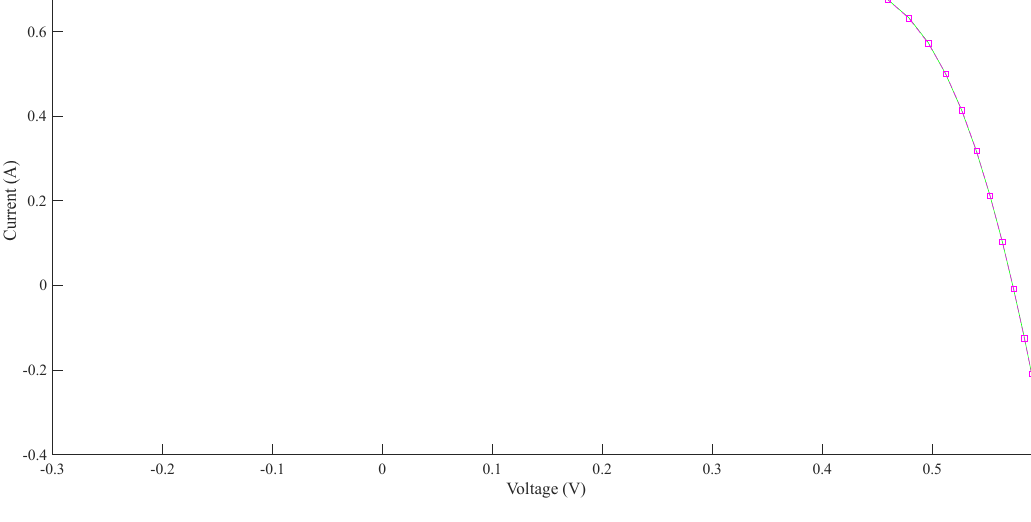
Figure 3. The current-voltage characteristics of RTC silicon photovoltaic cell (SDM).